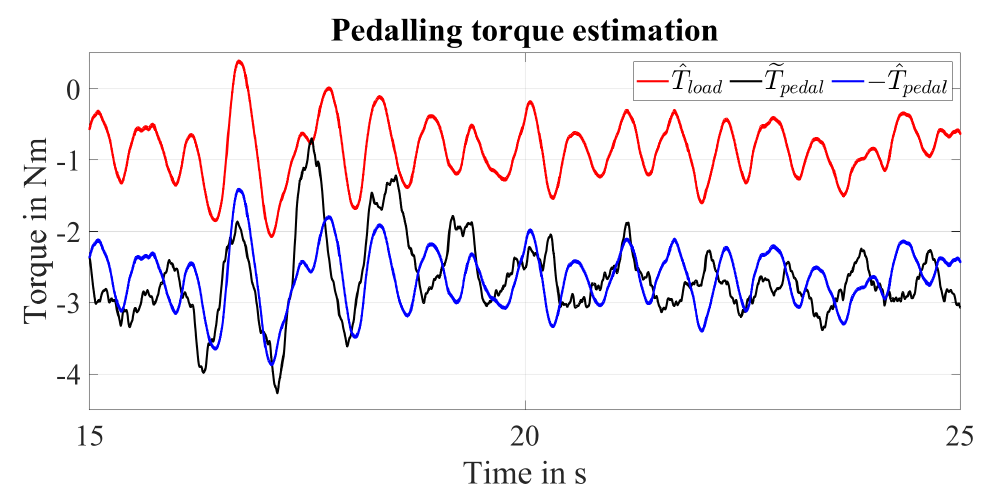
Figure 15. Experiment E4 : Comparison between the estimated load torque, the reconstructed pedalling torque and the estimated pedalling torque with opposite sign in steady-state